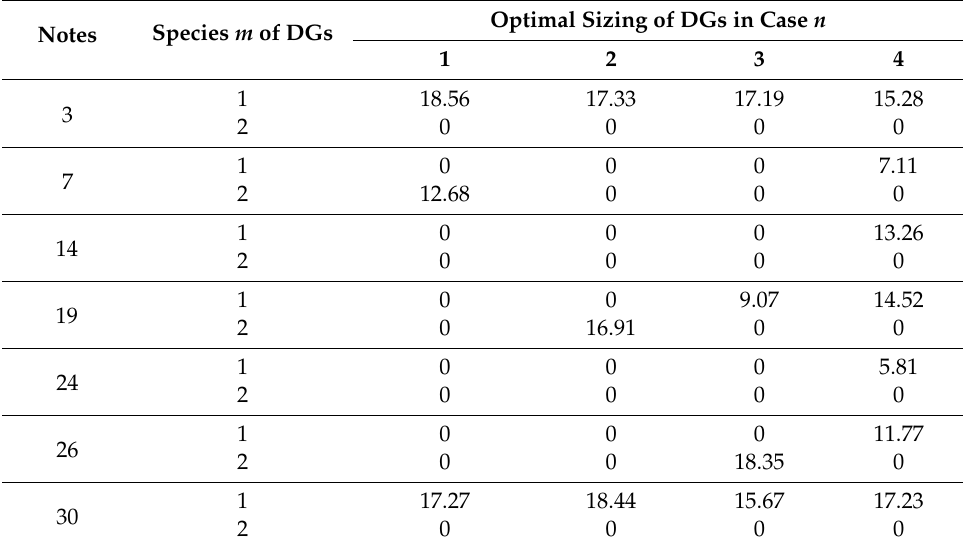
Table 3. Optimal sizing and siting of DGs in case n